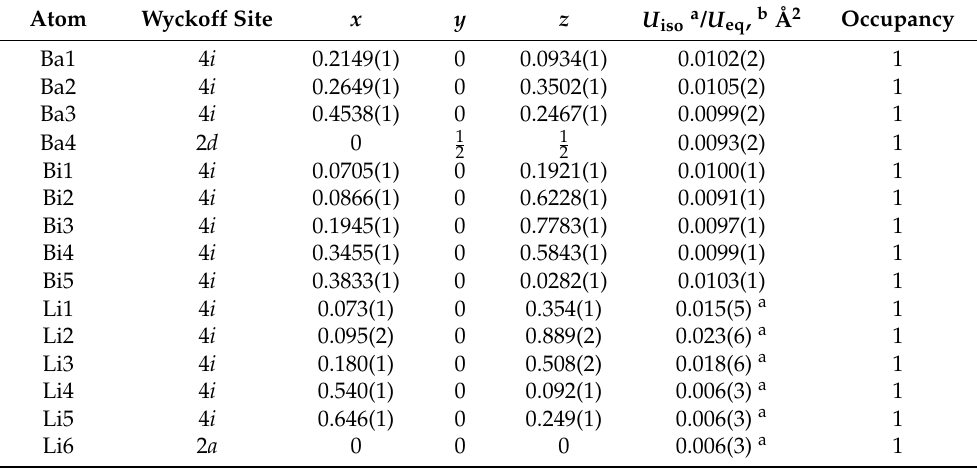
Table 8. Final refined positional coordinates and displacement parameters for Ba 7 Li 11 Bi 10